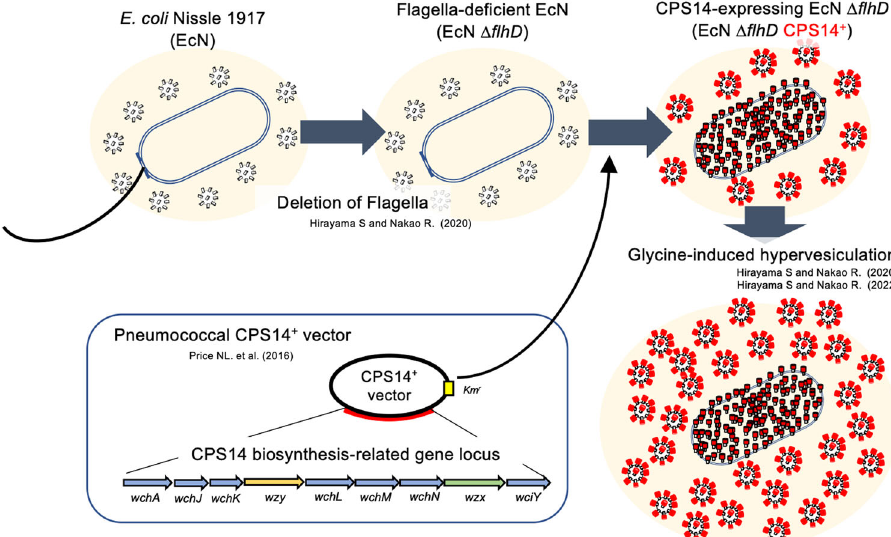
Fig. 1 Schematic representation of the manufacturing process of probiotic E. coli MVs expressing pneumococcal CPS14. A large quantity of MVs with reduced endotoxin content was isolated from the supernatant of a fl agella-de fi cient probiotic E. coli clone (EcN Δ fl hD ) cultured in LB broth supplemented with 1% glycine 16,17 . A pneumococcal CPS14 expression vector containing the entire CPS biosynthesis-related gene locus 10 was introduced into the EcN Δ fl hD strain. The resultant MVs expressed a chimeric LPS in which an E. coli O6 antigen repeating unit was replaced by a pneumococcal CPS composed of the serotype 14-speci fi c tetra-saccharide repeating unit galactose-1-phophate-( β 1-4)-N- acetylglucosamine-1-phosphate-( β 1-3)-galactose-1-phophate-( β 1-4)-glucose- 18